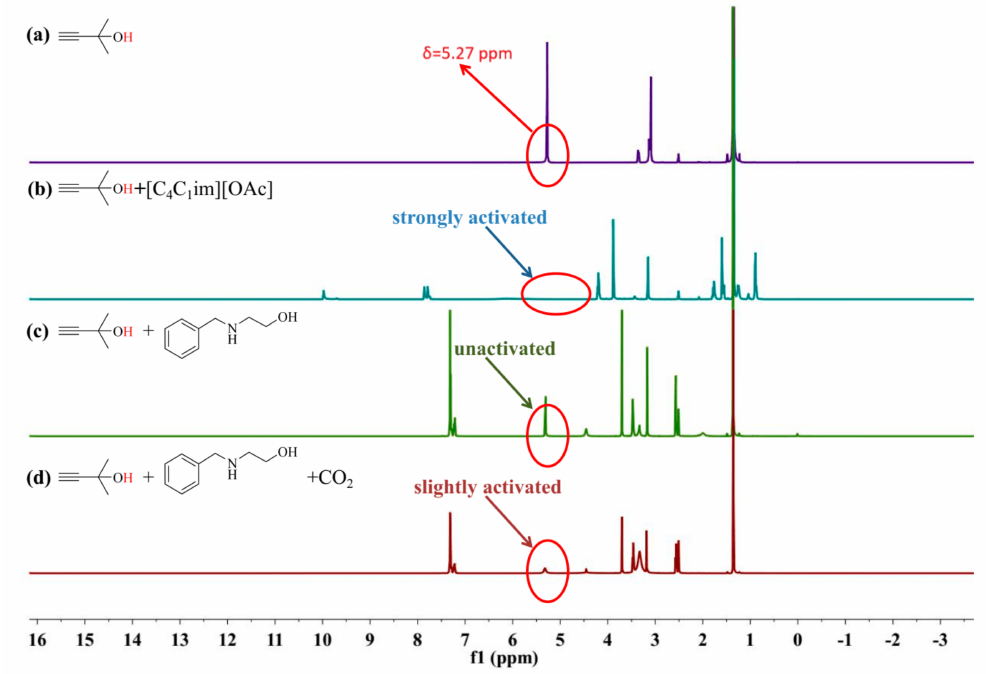
Figure 2. Investigations on the activation of hydroxyl